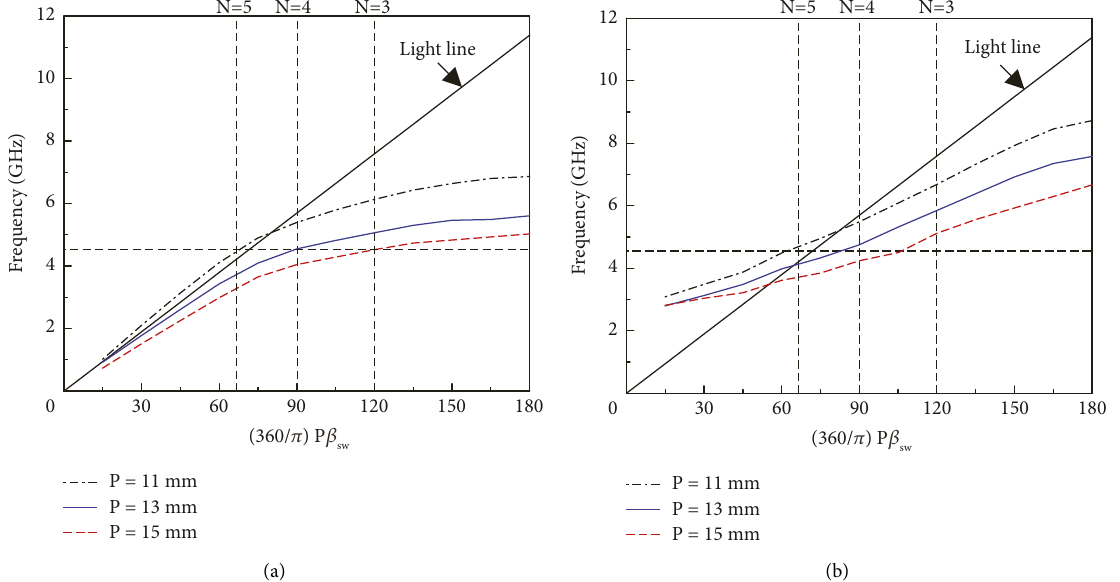
Figure 2: Dispersion diagram of a unit cell with g � 0.2mm: (a) 1st mode and (b) 2nd mode.